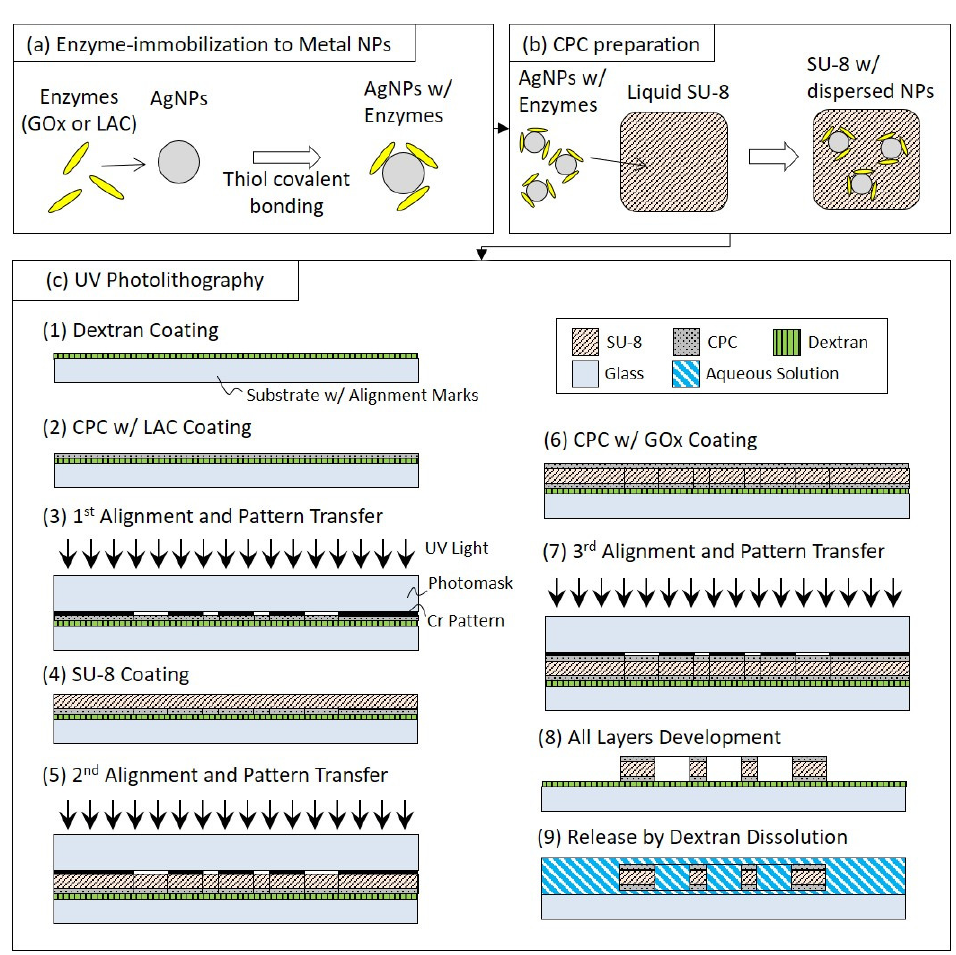
Figure 4. Fabrication process. ( a ) Enzyme-immobilization to metal NPs with a covalent bonding method using SAM of alkanethiols. ( b ) CPC preparation by dispersing the enzyme-immobilized metal NPs in uncured SU-8. ( c ) UV photolithography with mask pattern